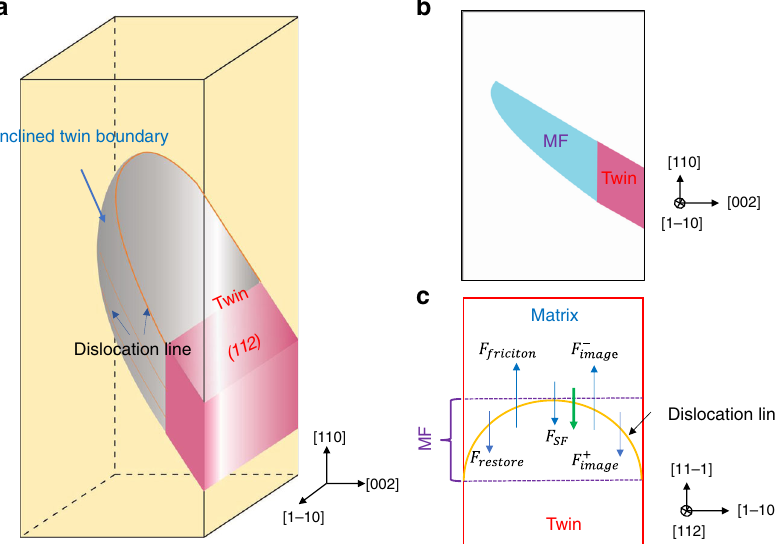
Fig. 4 Schematic of the inclined twin boundary (Moiré fringes (MFs) region) and associated detwinning in the nanocrystal. a The three-dimension twin structure with the inclined twin boundary in the nanocrystal. The curved dislocation lines are marked by the orange line on the twinning plane (112) and the inclined twin boundary is marked by the gray hook surface. b The front view of MF along [1-10]. MF region — the projection of the inclined twin boundary region and the fully grown twin are marked by the blue and red polygons, respectively. c One selected twinning plane in the twin. One individual curved twinning partial on the twinning plane (112), mainly suffering four forces, the restoring force F , the stacking-fault force F , the positive and negative restore SF image forces, F þ and F (cid:2) , respectively, and the friction force F under unloading. The detwinning direction is indicated by the bold green friction image image